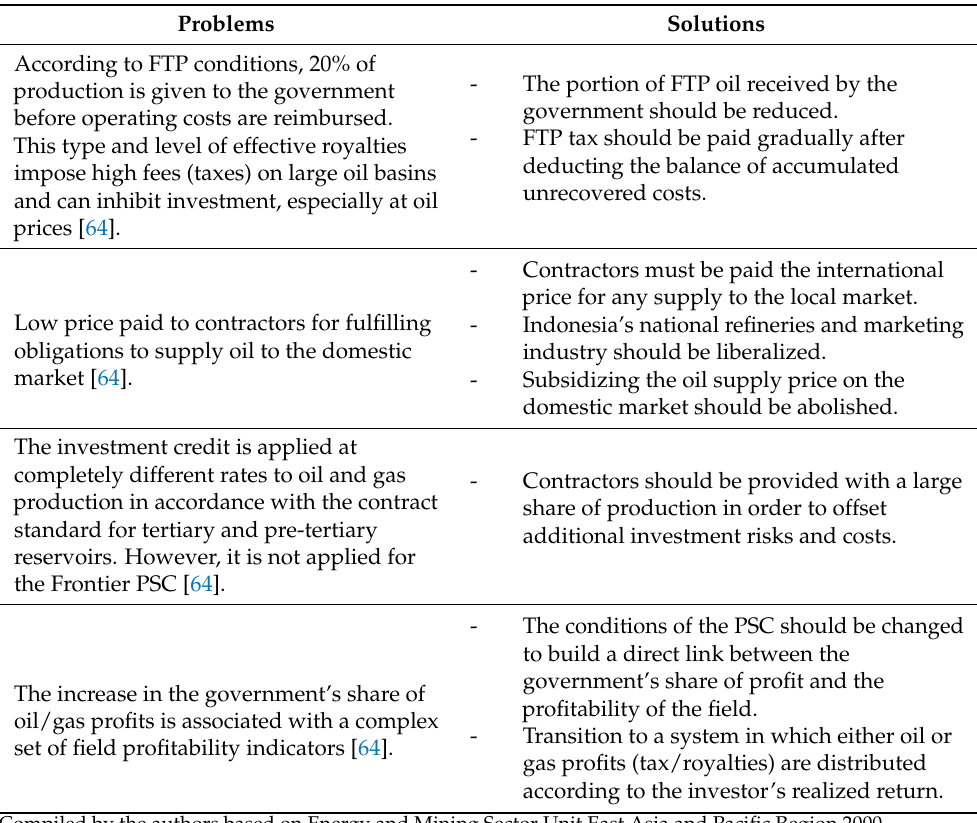
Table 3. Analysis of problems and possible solutions for the development of the PSC system in